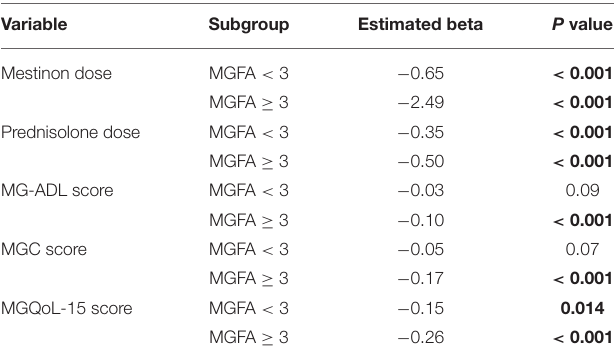
TABLE 2 | A summary of outcome changes in each subgroup during the trial period.